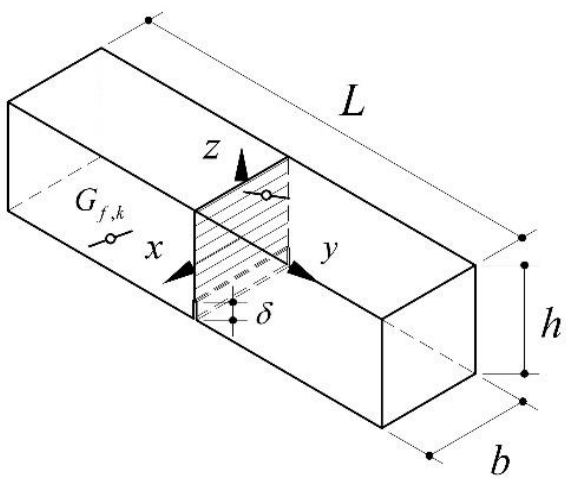
Figure 1. Schematic representation of the 3D HPFRC beam: adapted from [43]. By denoting x , y , and z , the axes of a Cartesian coordinate system originating at the centre of the midspan section, a random distribution of the fibres inside the specimen prismatic volume was generated (by utilising the standard random number generator of Matlab) in which x , y , and z (with 𝑘 between 1 and n ( f,k ) ( f,k ) ( f,k ) three coordinates of the fibre centroid ( G ( f,k ) ) and the two relevant angles, respectively. In order to consider the bridging effect offered by the fibres, the total number of fibres in the midspan section, n f , was determined as a ratio between the fib res’ volume fraction, V f , and the cement matrix volume, V c . Furthermore, the model was based on the following assumptions: (i)